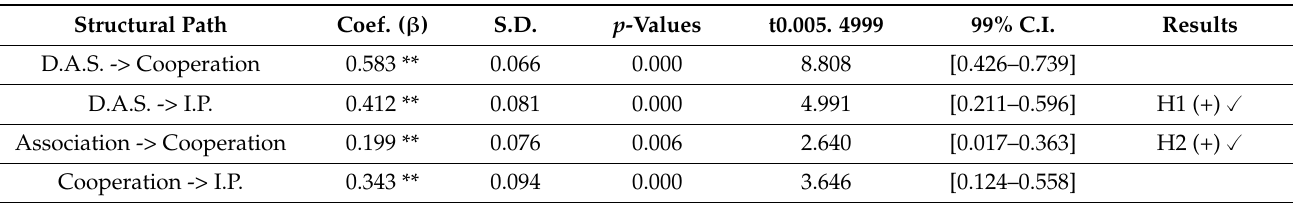
Figure 3. Path coefficients and significance levels of the proposed model. Table 6. Summary of direct effects.